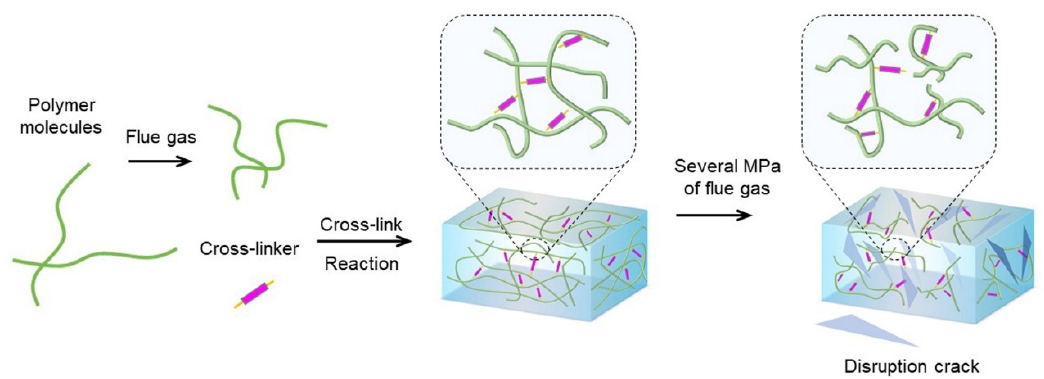
Figure 15. Schematic illustration of the generation and disruption of polymer gel in a flue gas envi- ronment.